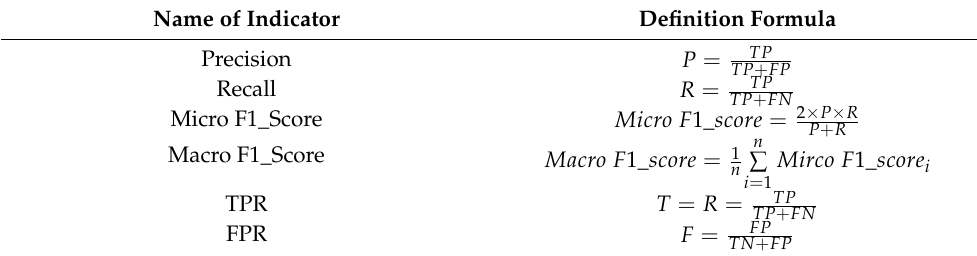
Table 2. Evaluation indicators.